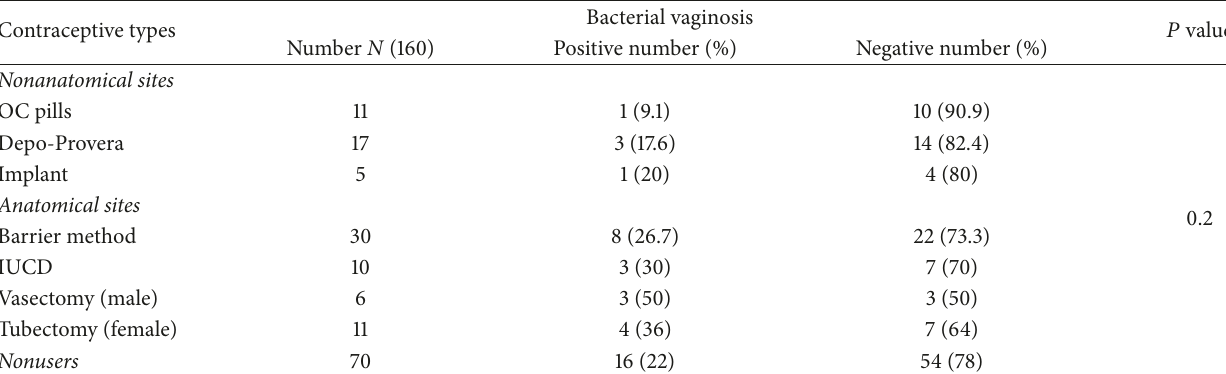
Table 4: Distribution of BV using different